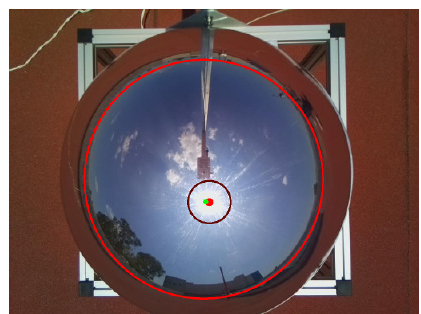
Figure 8. Sun detection (red dot) and tracking (green dot).